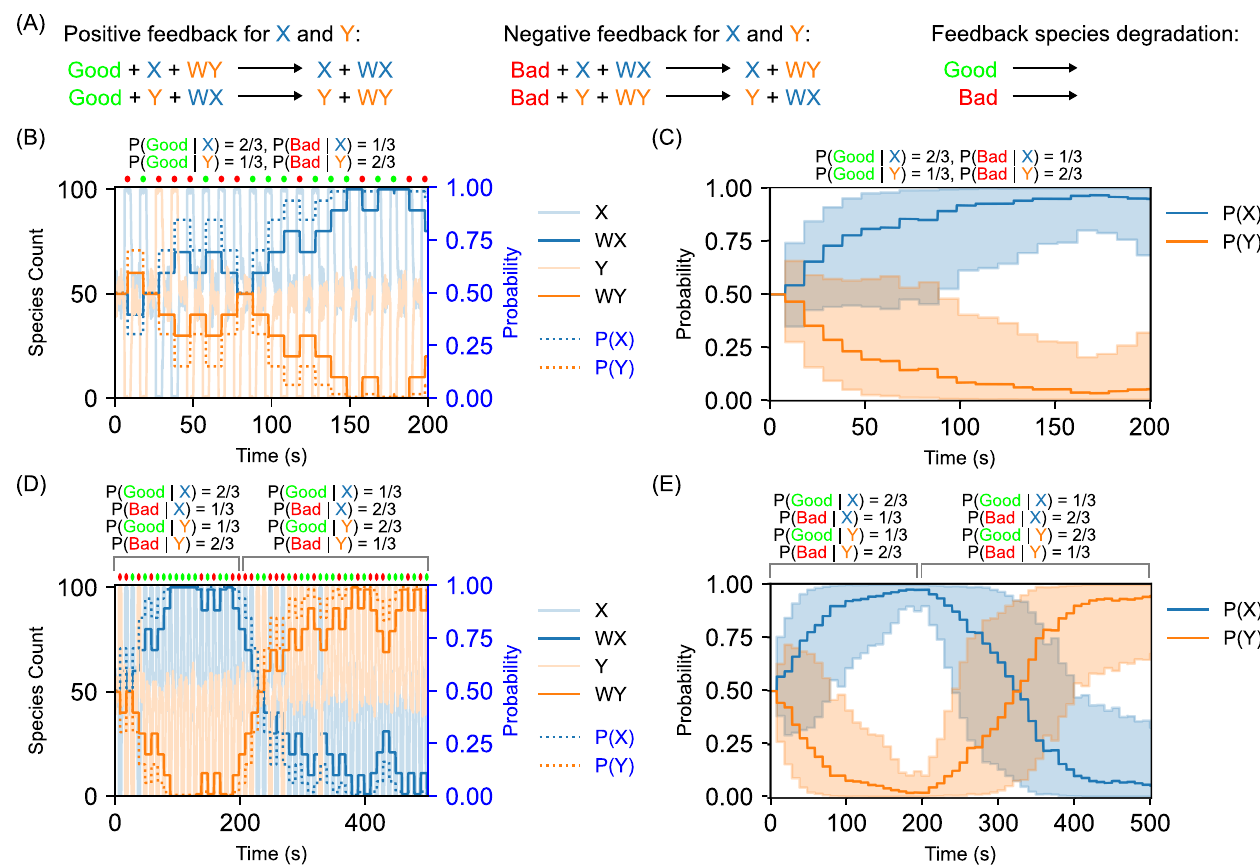
Fig 3. Operant conditioning of stochastic CRNs in environments with probabilistic feedback. (A) Additional reactions to provide feedback response capabilities to the decision-making CRN presented in Fig 1D. The positive feedback species “ Good ” converts WY to WX in the presence of X and converts WX to WY in the presence of Y . Thus, the WX weight is increased for the next round when “ Good ” feedback is observed in the presence of the X decision species, and similarly for WY . The negative feedback species “ Bad ” works in the opposite direction, converting WX to WY in the presence of X (thereby disfavoring the X choice in future rounds) and similarly converting WY to WX in the presence of Y . The feedback species degradation reactions serve to drain away any excess feedback species in the case where there are not sufficient decision or weight species present to drive consumption of the feedback species, thus ensuring that they do not linger in the system and influence future feedback rounds. The rate constants for the positive and negative feedback reactions are kFB = 1. The rate constants for the feedback species degradation reactions are kFBDeg = 1. (B) Representative time course from an operant conditioning simulation in a constant environment that administers probabilistic feedback based on CRN decisions. Starting with 50 of each weight species, 20 stimulus/relaxation cycles are performed. The environment responds probabilistically by supplying feedback in the form of 10 molecules of either Good or Bad species, based on which of the decision species is above a threshold of 90 molecules at the time feedback is calculated. If decision X was taken, the conditional probabilities of the feedback responses are 2/3 for Good and 1/3 for Bad , and if decision Y was taken, these probabilities are 1/3 for Good and 2/ 3 for Bad . Rate constant values are as outlined in Fig 1 and above. Here and henceforth, the small discs above the trace show whether positive (green) or negative (red) feedback was administered in that round. Species counts for X , Y , WX , and WY are plotted on the left-hand axis. The corresponding decision probabilities P ð X Þ and P ð Y Þ are plotted on the right-hand axis; these are calculated by using the “ kBias = 30” transfer curve from Fig 2 as a calibration to convert weight species counts into the corresponding probabilities. In this example, positive and negative reinforcement from the environment drives the system to favor the X response as this is more likely to elicit positive feedback and less likely to elicit negative feedback. (C) Results from 50 distinct stochastic simulations of the conditioning experiment from part (b), plotting the averaged decision probabilities only. Line indicates the mean; shaded area represents one standard deviation above and below the mean. (D) Representative time course from an operant conditioning simulation in a dynamic environment that administers probabilistic, time-dependent feedback based on CRN decisions. Starting with 50 of each weight species, 50 stimulus/relaxation cycles are performed. Initially, the environment responds with probabilities as in part (b), however, at time t = 200 the probabilities are switched. Rate constant values are as outlined in Fig 1 and above and probabilities are calculated as described in part (b). In this example, the change in the response probabilities at time t = 200 demonstrates the ability of the system to adapt to this change and switch itself from a high probability of the X response to a high probability of the Y response. (E) Results from 50 distinct stochastic simulations of the conditioning experiment from part (d), plotting the averaged decision probabilities only. Line indicates the mean; shaded area represents one standard deviation above and below the